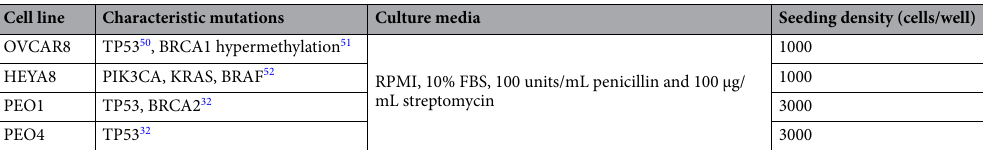
Table 3. Selected panel of human OC cell lines and their relevant mutations, culture conditions, and 96-well plate seeding densities used for in vitro combination cytotoxicity studies.